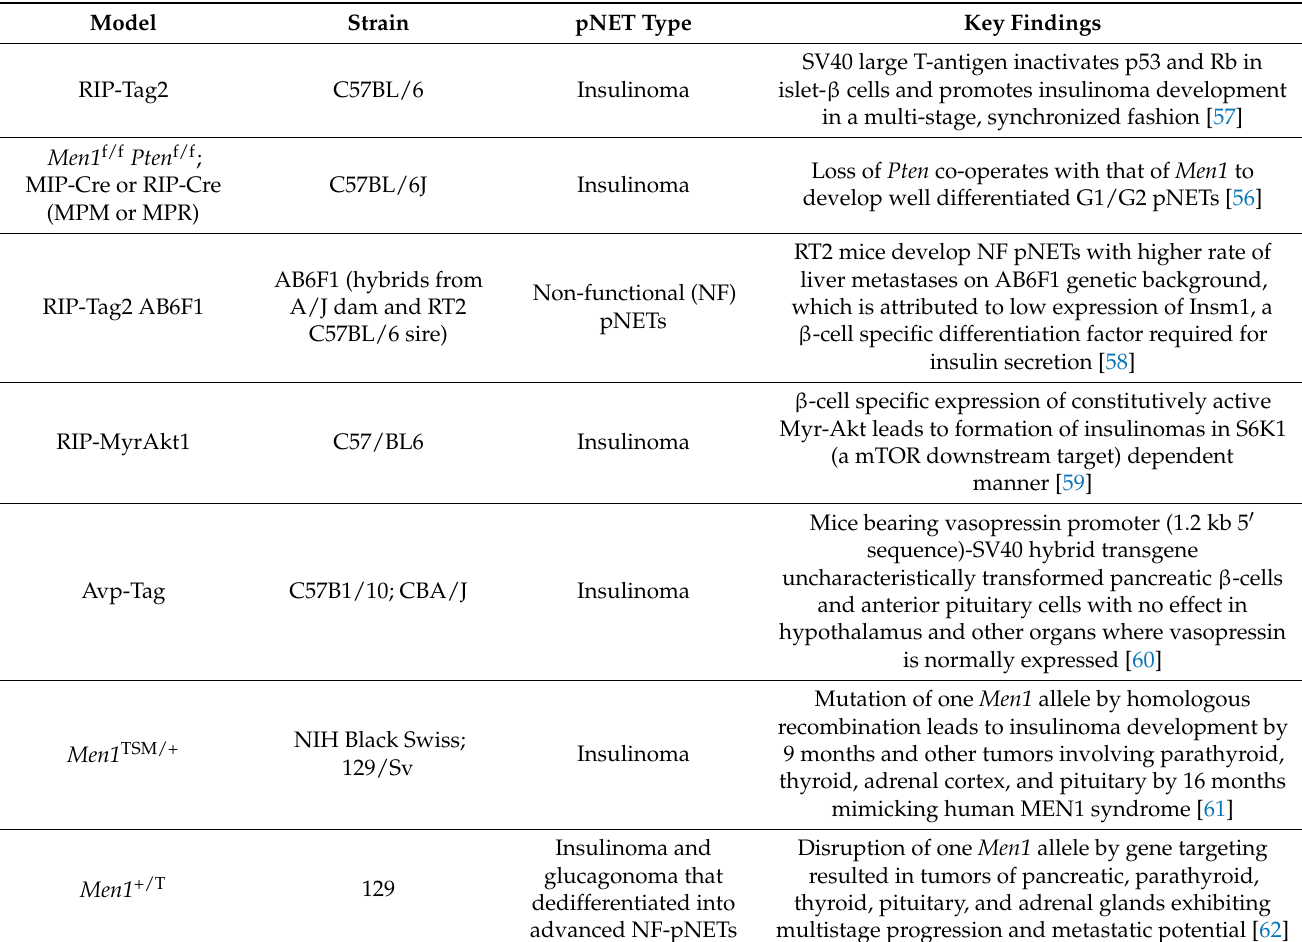
Table 2. Genetically engineered pNET mouse